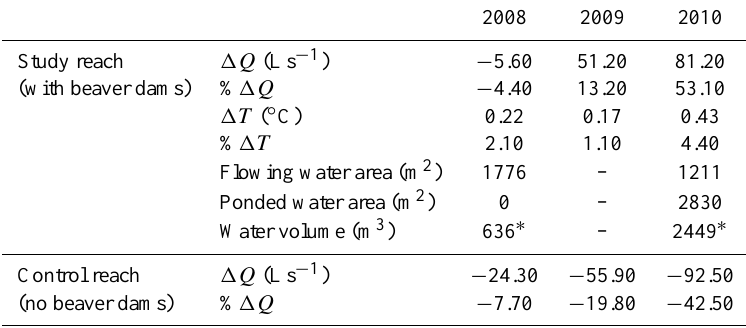
Table 3. Annual change in flow ( (cid:49)Q ) and annual percent net change (% (cid:49)Q ) for the study reach impacted by beaver dams (shown in Fig. 1) and for an adjacent, upstream control reach with no beaver dams present. Change in stream temperature ( (cid:49)T ), percent change (% (cid:49)T ), and area of flowing water and ponded water area for the study reach impacted by beaver dams is listed as well. Change in flow and temperature and their percentages ( (cid:49)Q , % (cid:49)Q , (cid:49)T , % (cid:49)T ) were calculated as an average of daily (cid:49) values for each year (Figs. 3, 5).